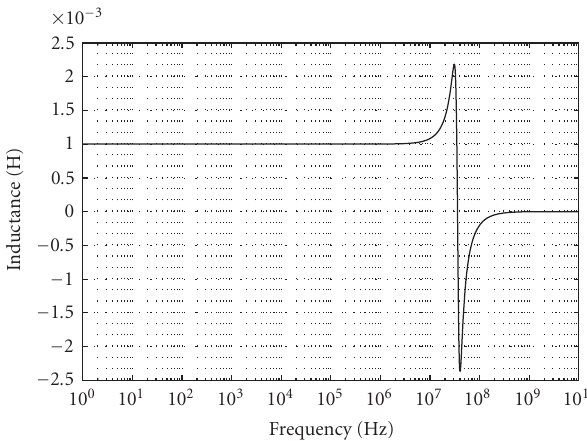
Figure 13: Phase response of BPF using simulated grounded inductor.